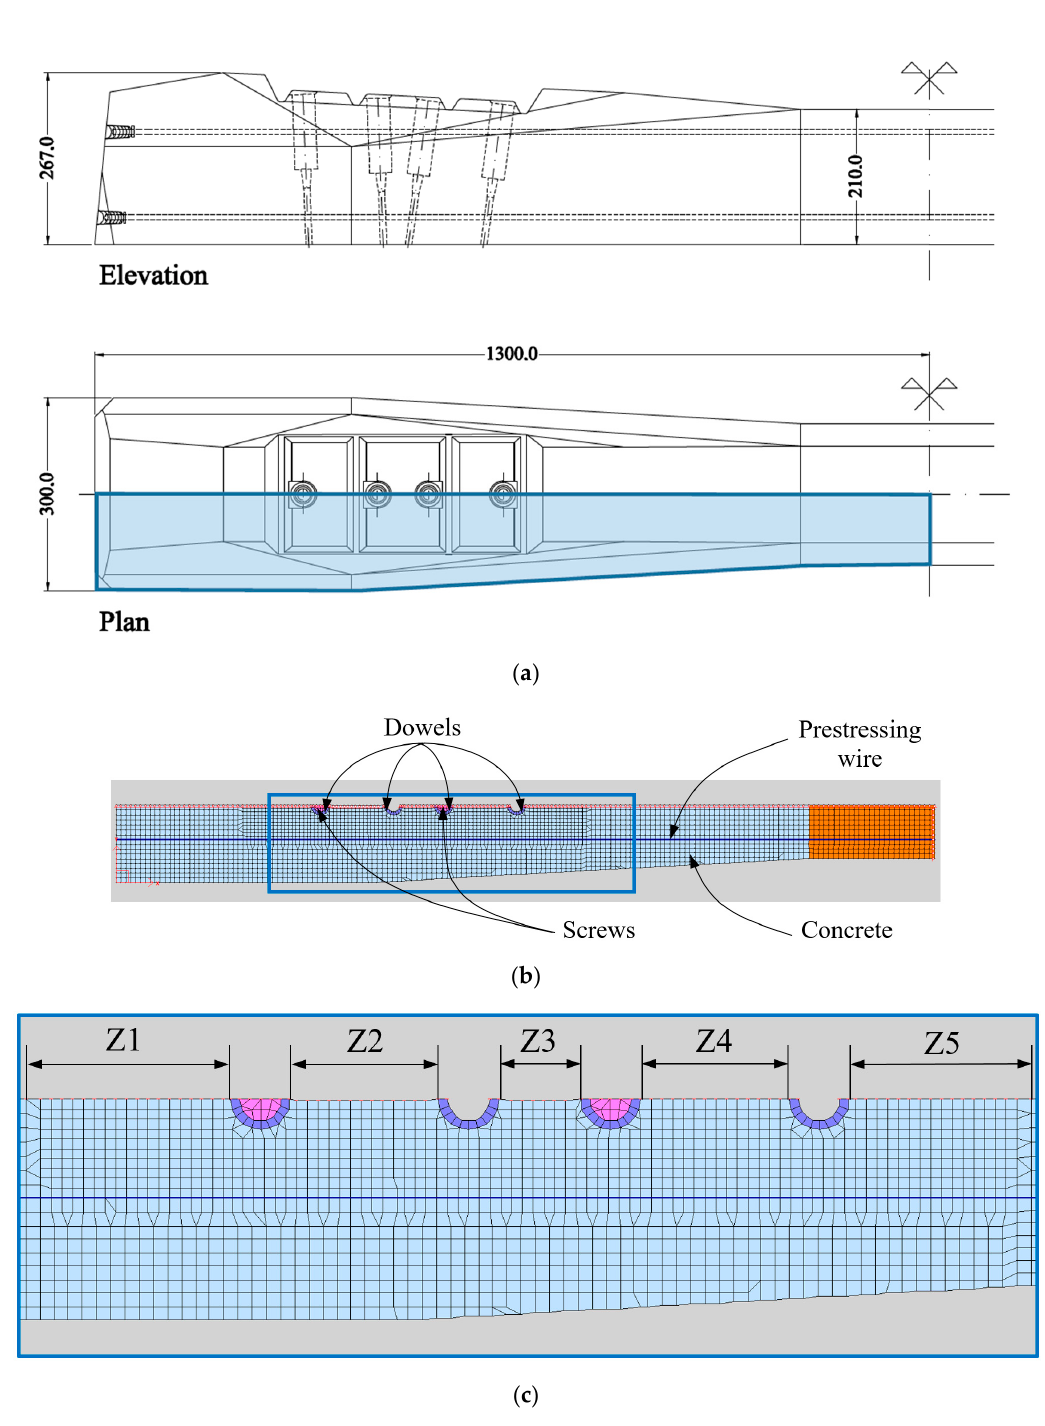
Figure 4. Scheme of the bidimensional numerical model: ( a ) detail of one half of a sleeper; ( b ) boundary conditions and components of the numerical model; ( c ) detail of the zones considered in the analysis.